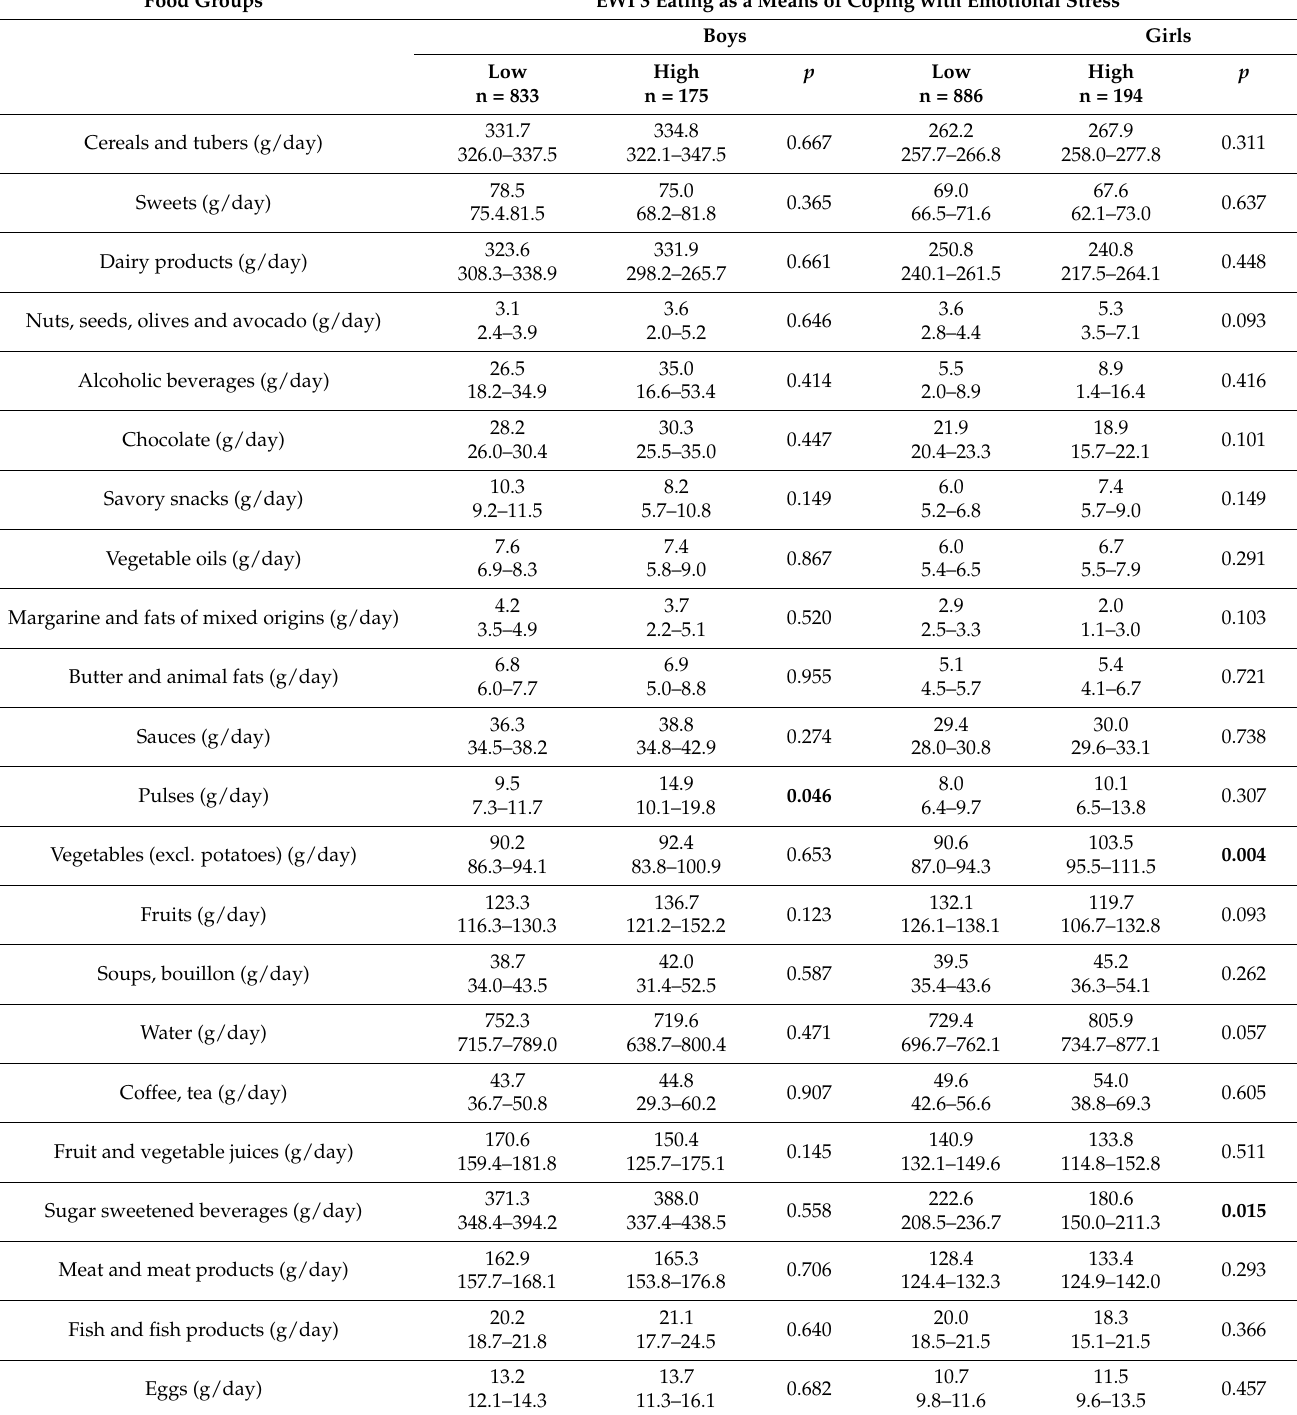
Table 4. Mean (95% CI) intake of food groups by levels of the eating as a means of coping with emotional stress component (EWI 3) in adolescents from the HELENA